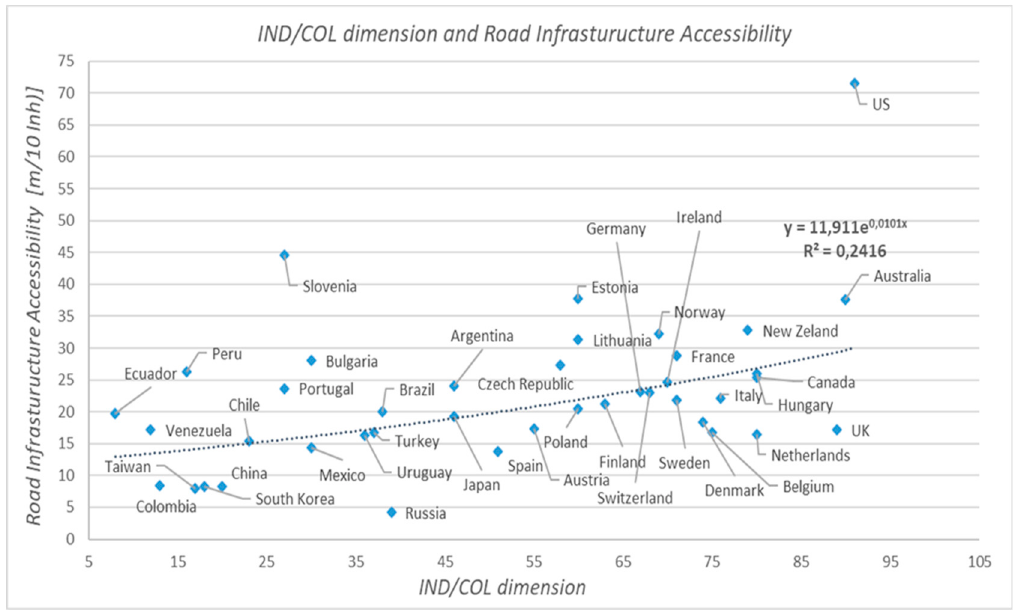
Figure 2. Drive mode share over individualism-collectivism dimension.